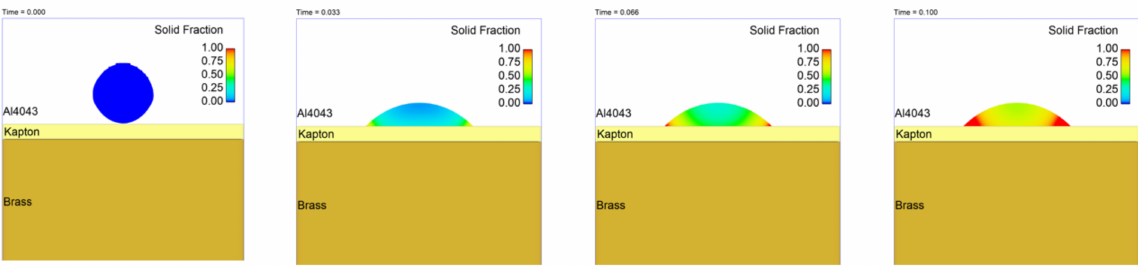
Figure 5. Fluid fraction of impinging droplet and the solidification front at different times. Solid fraction of 1 implies a fully solid region.